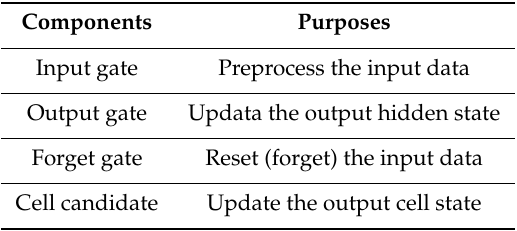
Table 4. Four components of the LSTM network to avoid the vanishing gradient problem in the RNN.